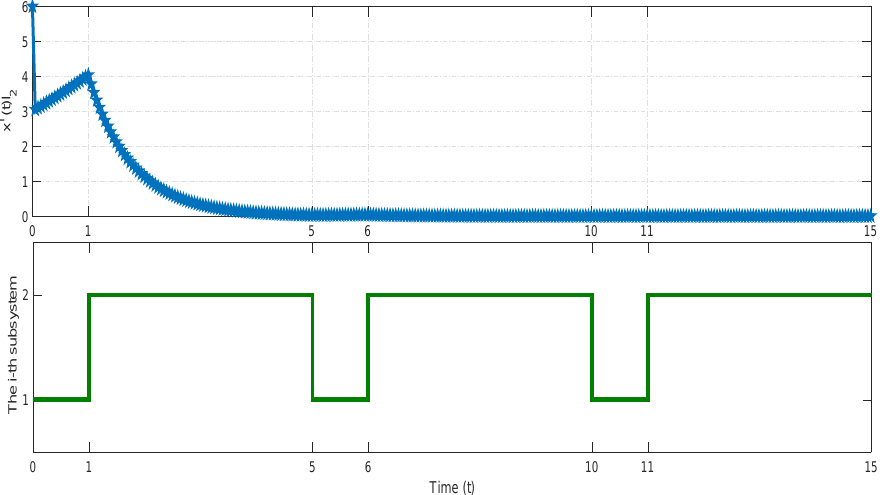
Figure 3. The value of x T ( t ) l 2 of the system in Example 1 under the corresponding switching